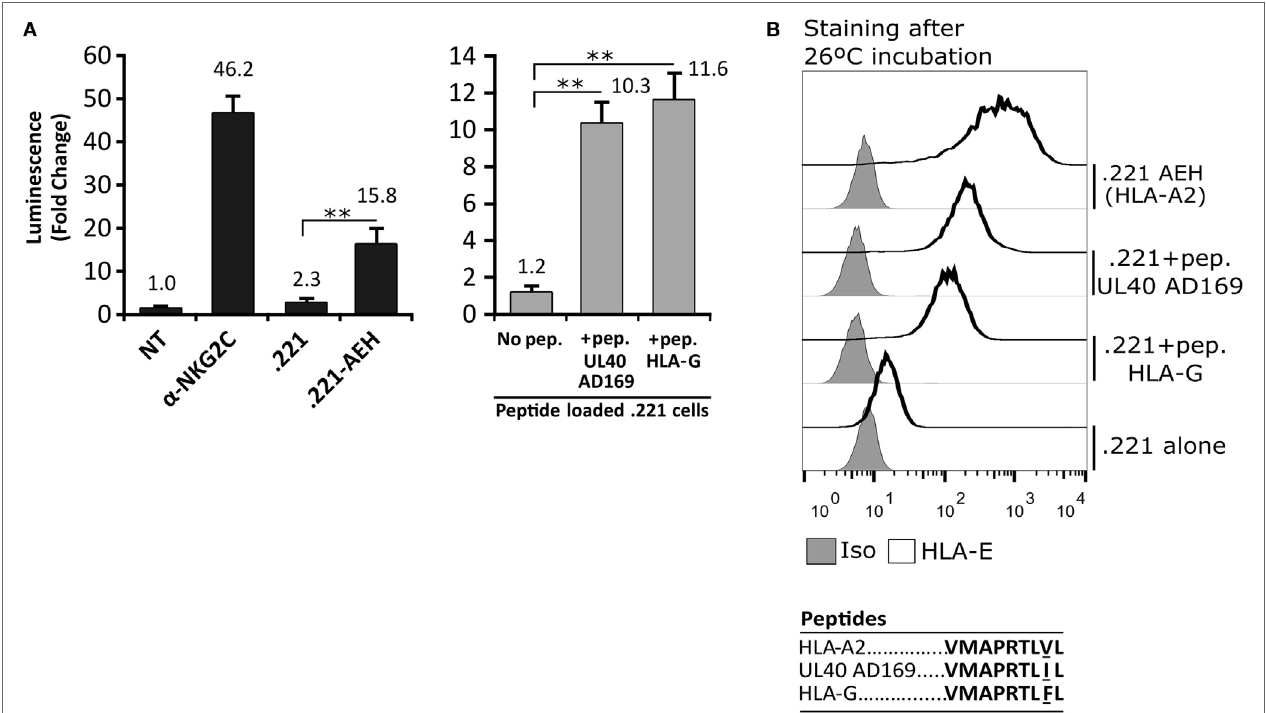
FigUre 3 | Activation of Jurkat-NKG2C + cells by HLA-E loaded with the canonical human cytomegalovirus UL40 leader sequence-derived synthetic peptide on 721.221 cells. (a) As described for Figure 2 , Jurkat-NKG2C + cells were: (a) untreated (NT), (b) stimulated with plate coated anti-NKG2C, or (c) cocultured with the .221 or .221-AEH cells (black bars). In parallel, the response of Jurkat-NKG2C + cells was assessed coculturing them with .221 cells preincubated at 26°C overnight with synthetic peptides corresponding to HLA-G (VMAPRTLFL) and AD169 UL40 (VMAPRTLIL) leader sequences, reported to stabilize HLA-E expression (gray bars). Data correspond to three independent experiments (mean ± SD). (B) HLA-E expression by .221-AEH and .221 cells preincubated with peptides prior to coculture with Jurkat-NKG2C + cells; gray histograms represent the isotype control. Statistically significant differences are indicated (** p <